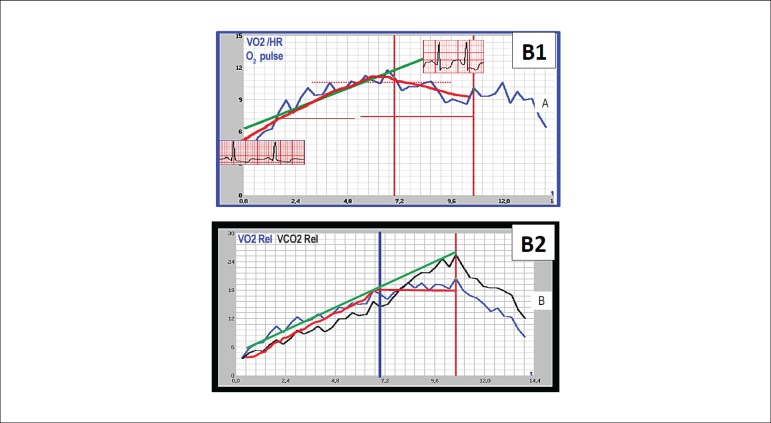
Cardiopulmonary exercise test in the pre-rehabilitation assessment of
a 57-year-old hypertensive, diabetic, overweight male patient with
three-vessel coronary disease, who refused to undergo myocardial
revascularization surgery eight years earlier. A) evident drop in
oxygen pulse. B) early plateau of oxygen consumption. Both changes
(A and B) were due to ischemic depression of the ST segment (evident
in A), followed by progressive chest pain.